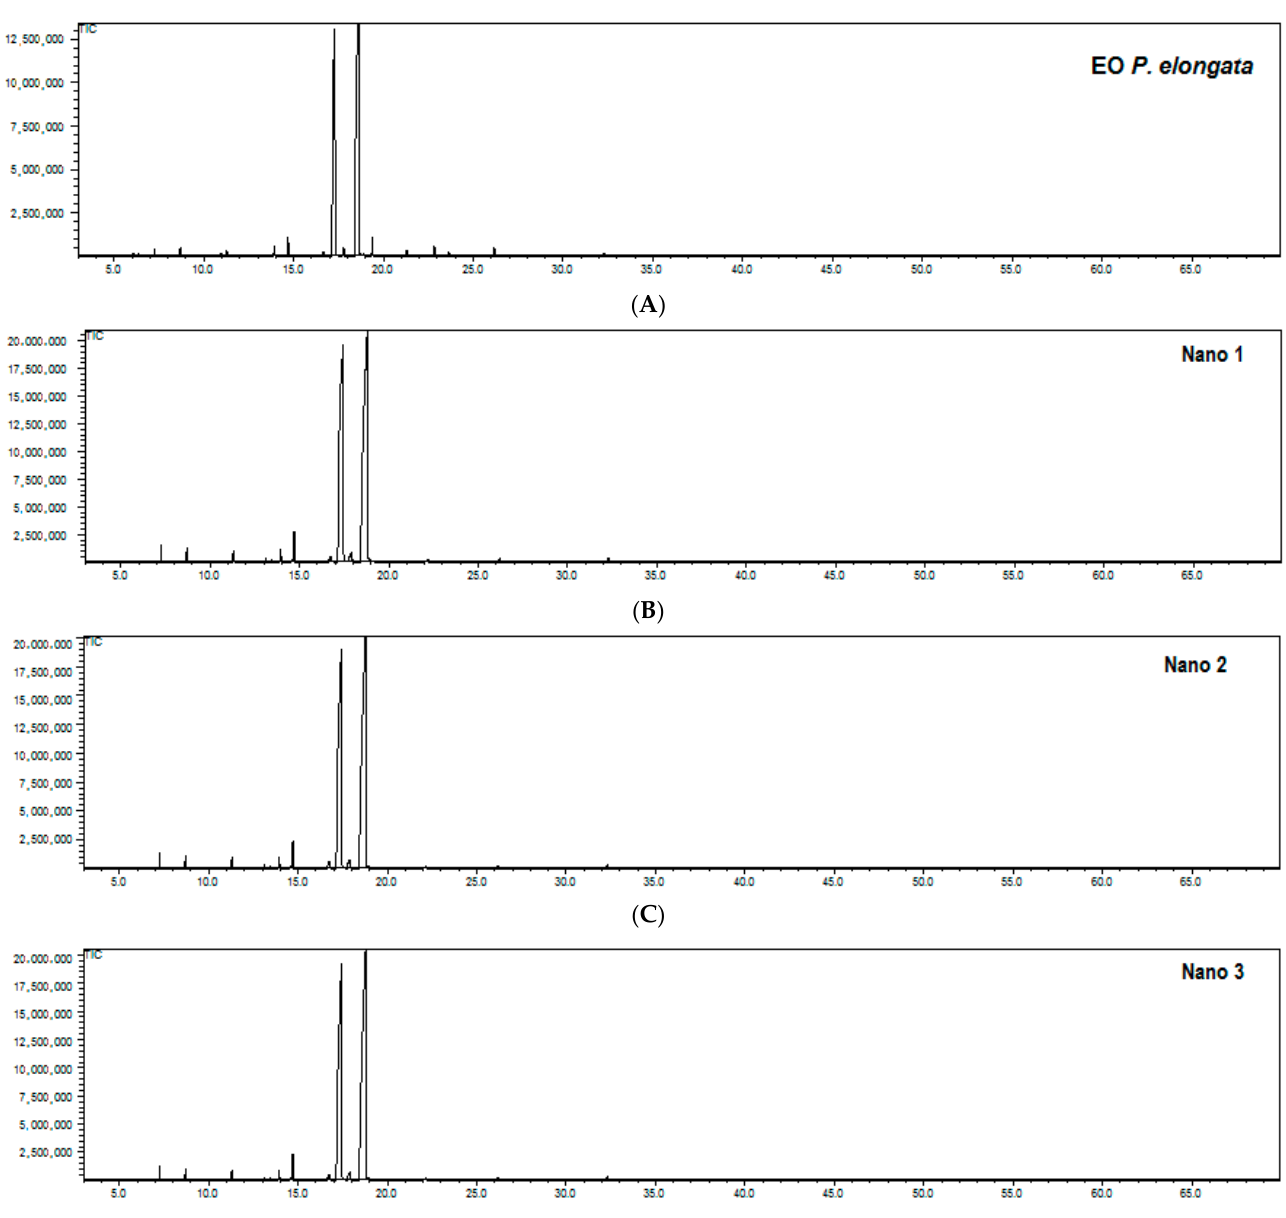
Figure 1. Total ion chromatograms of—from ( A – D )—the Pectis elongata essential oil and the three replicates of its nano-emulsions.